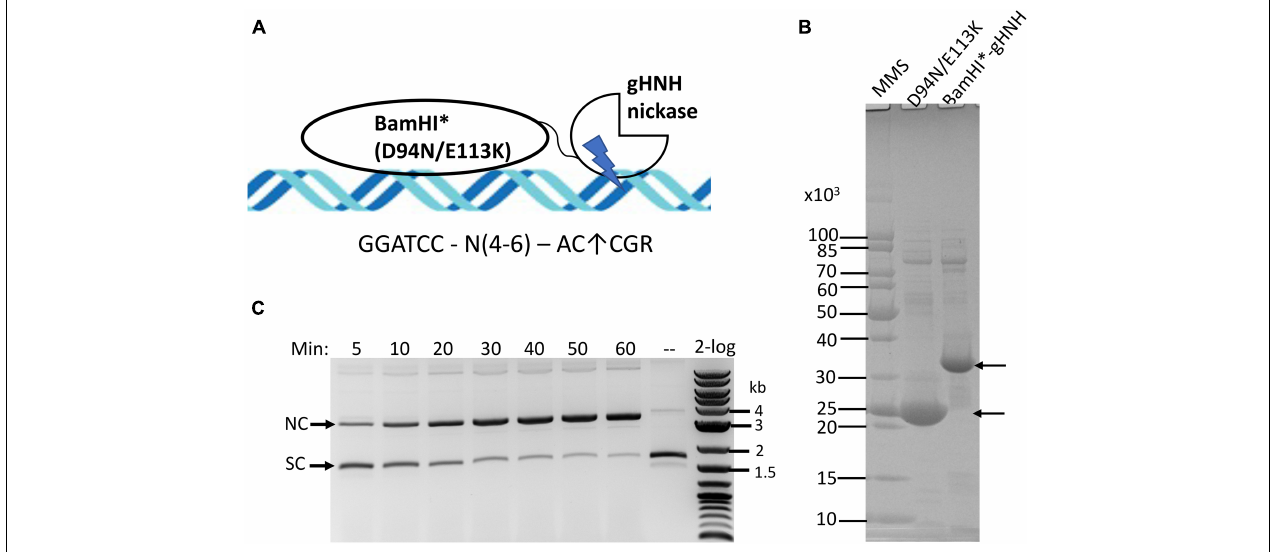
FIGURE 2 | Purification of Bam HI catalytic mutant ( Bam HI*)-gHNH fusion enzyme and nicking activity assay in the presence of divalent cations. (A) Schematic diagram of Bam HI catalytic mutant ( Bam HI ∗ ) in fusion with phage gHNH nicking domain (the size of DNA and protein domains are not shown in scale). The diagram is simplified to show the monomeric fusion only. (B) SDS-PAGE analysis of partially purified Bam HI ∗ -gHNH fusion protein. Lane 3, chitin column purified fusion protein (predicted molecular mass in ∼ 33.53 kDa). Following DTT cleavage overnight, eluants 1 and 2 from the chitin column were concentrated by low-speed centrifugation in centrifugal filter unit (Millipore, 10 kDa cut-off) and resuspended in an enzyme storage buffer. Approximately 20 and 5 µ g of the Bam HI mutant and fusion proteins were loaded in the gel. MMS, protein molecular mass standard in Daltons (Da) (NEB). (C) A time course (5–60 min) of pUC19 nicking digestion (partial) by the fusion enzyme in NEB buffer 2 supplemented with MnCl 2 . Approximately 80% of supercoiled DNA was converted to nicked circular form after 1 h nicking reaction. A weak linear band also appeared. SC and NC, supercoiled and nicked circular DNA, respectively. 2-log, DNA size ladder (100 bp to 10 kb,